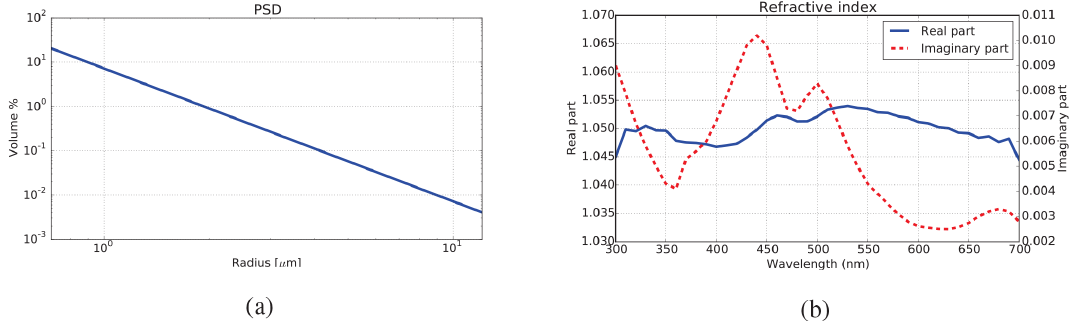
Figure 4. (a) PSD for the test run with spherical-shaped homogeneous particles. (b) Complex refractive index signature postulated for spherical-shaped homogeneous particles.